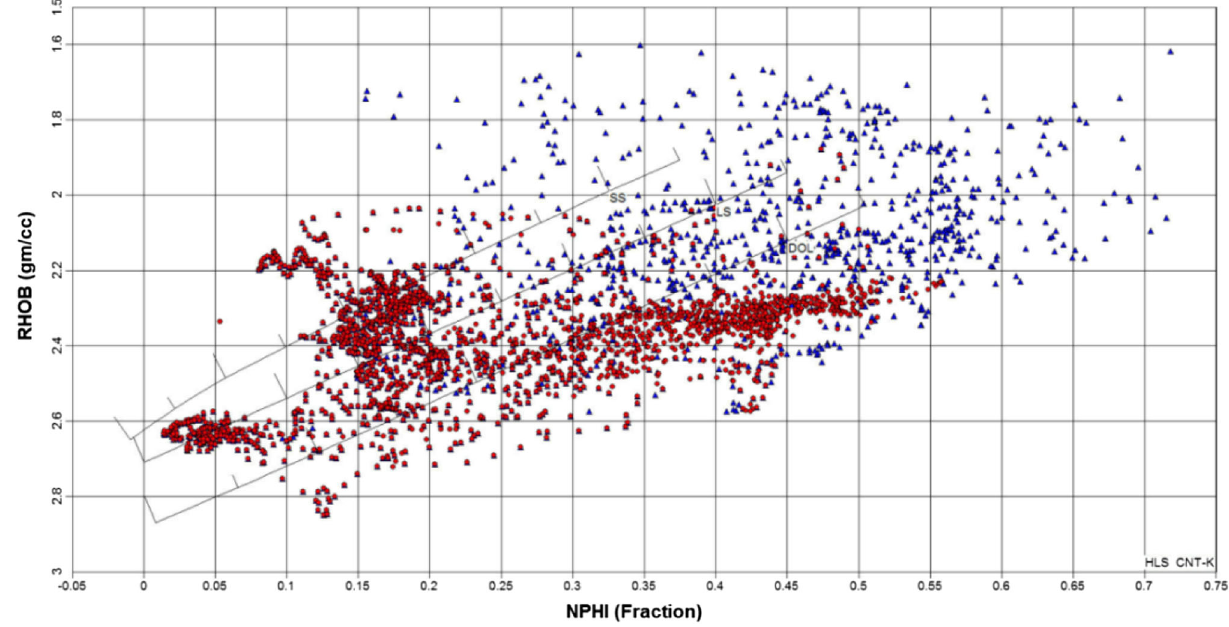
Fig. 6 Well A is conditioned by RHOB and NPHI ( red ) on top of measured RHOB-NPHI ( blue